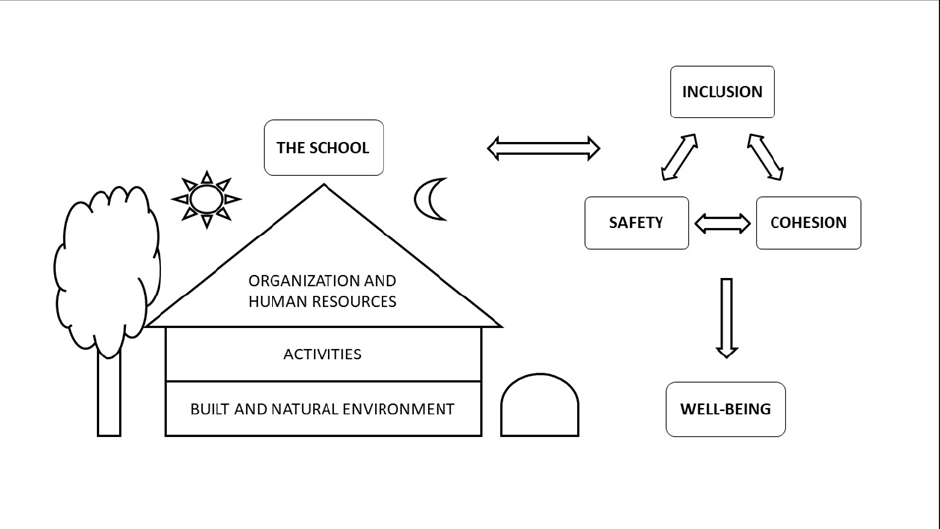
Figure 1. Factors associated with well-being in the community school.